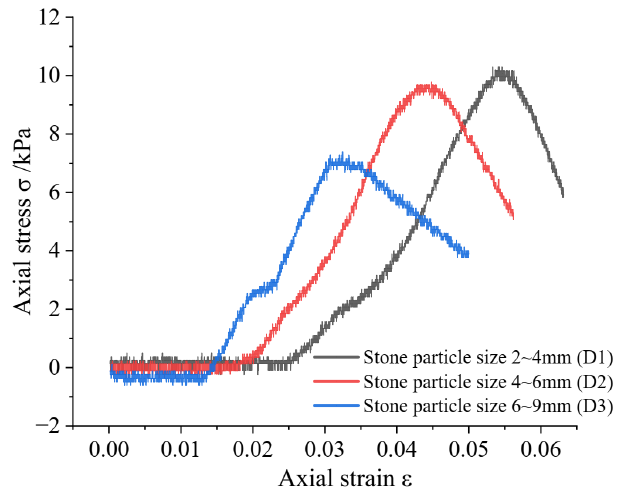
Figure 7. Stress–strain curve of soil–rock mixture sample with rock content of 50%.